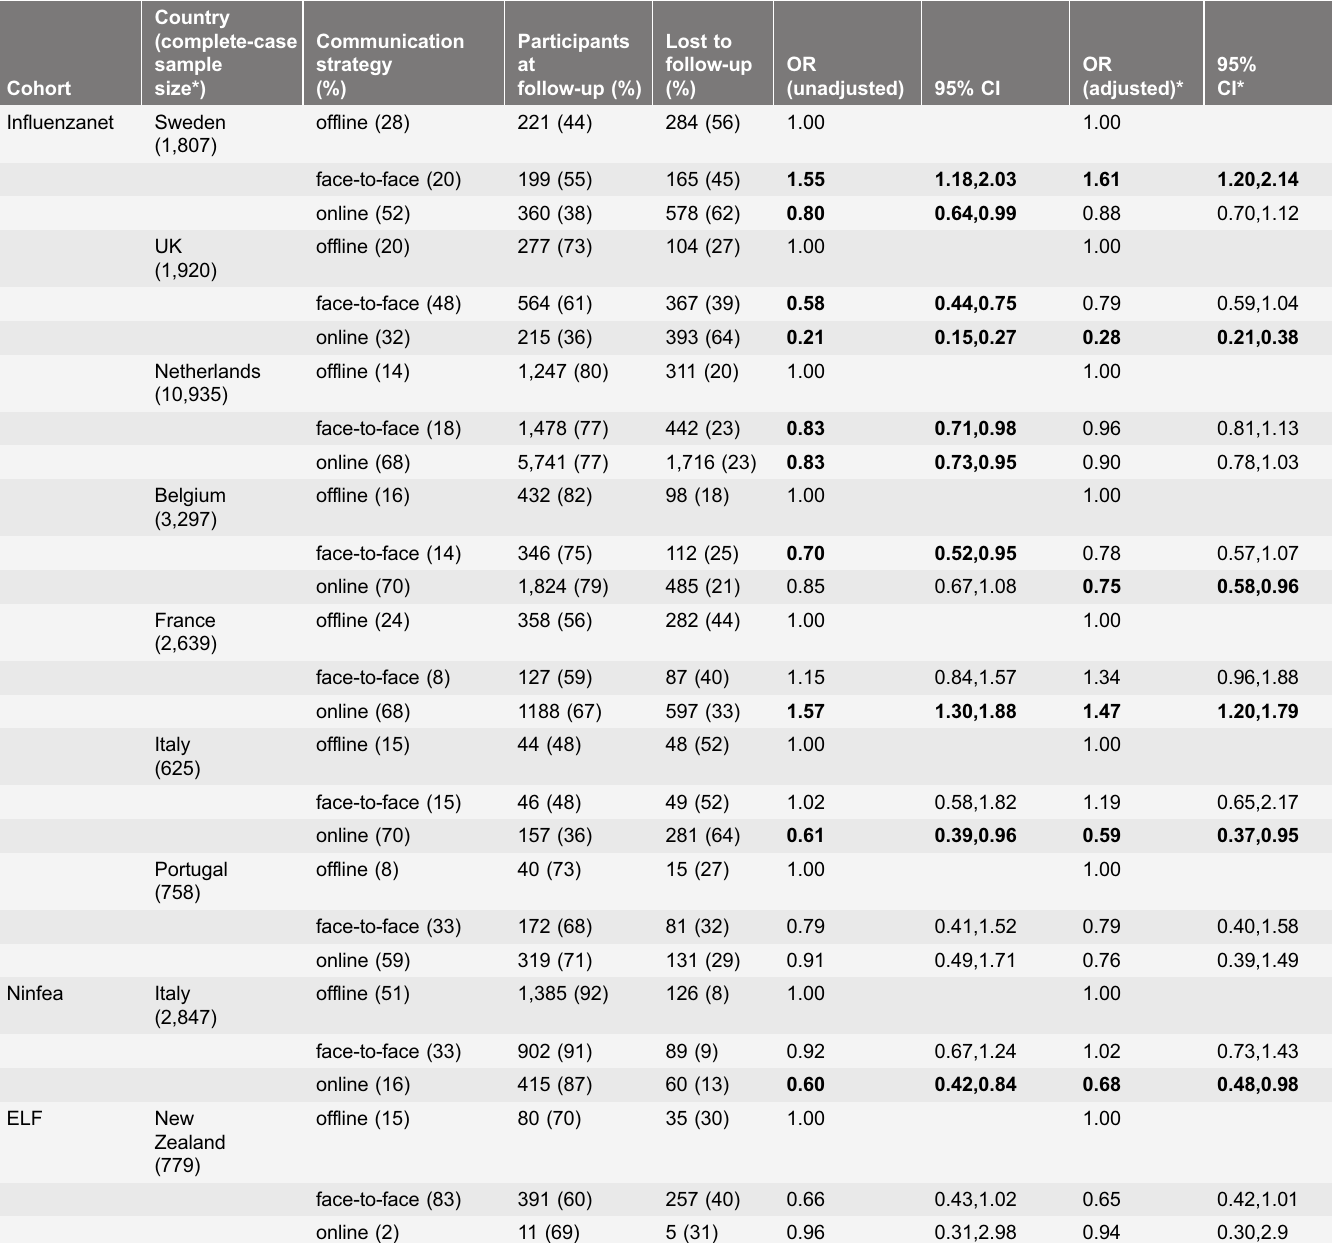
Table 2. Follow-up participation proportion, unadjusted odds ratios and odds ratios adjusted for the variables detailed in the Methods section and confidence intervals are shown for different recruitment methods of individuals enrolled in the Influenzanet study (stratified by country), Ninfea and ELF. Country (complete-case sample Cohort size*)